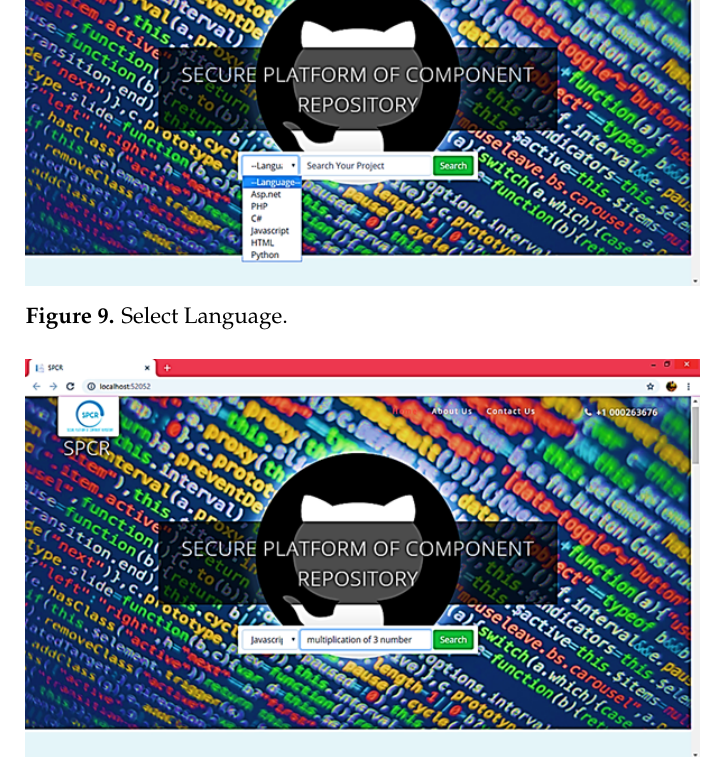
Figure 10. Select component/function for